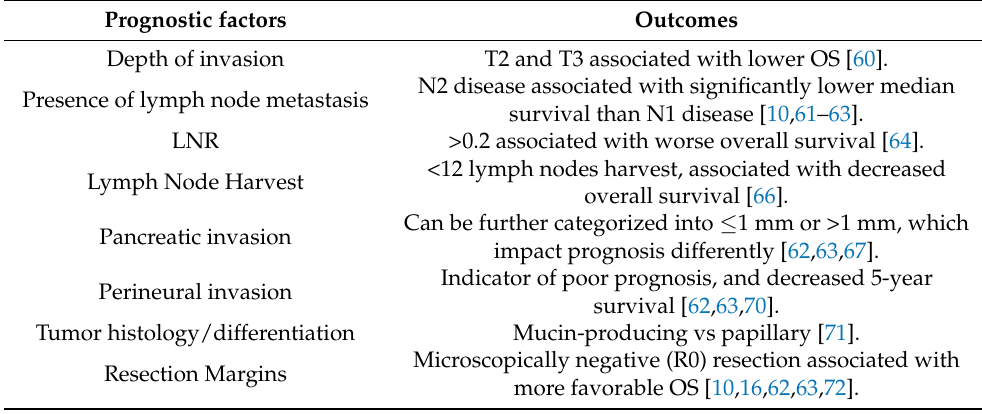
Table 2. Prognostic factors for distal cholangiocarcioma.